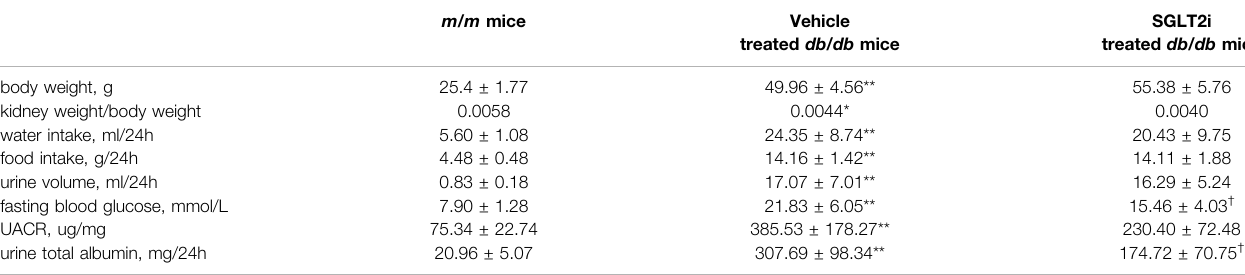
TABLE 1 | Laboratory data of mice.